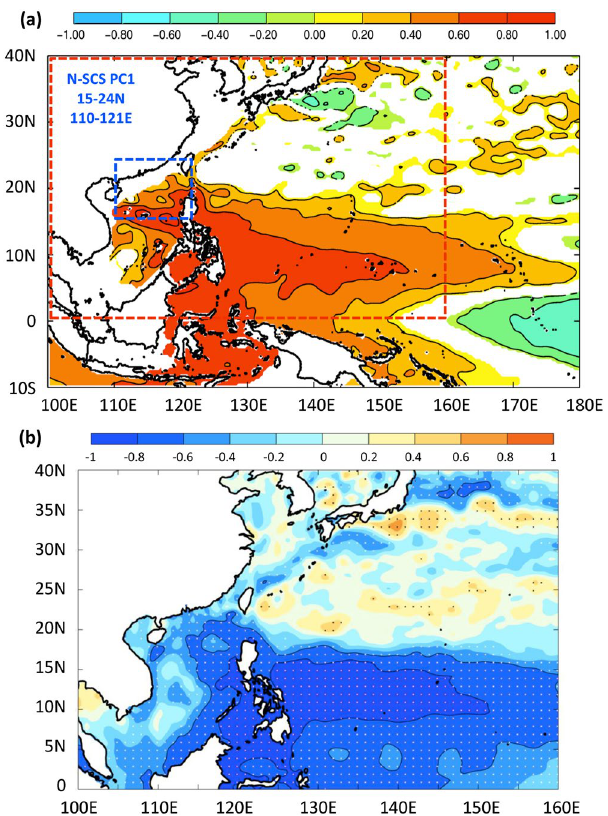
Figure 4. ( a ) Homogeneous correlation map of mode-1 northern SCS EOF( η ’) (57%; domain shown in blue) with AVISO SLA in the western North Pacific from 1993–2013, showing that the SCS η ’ is closely related to the SLA fluctuations over the warm pool, in particular to the fluctuations in the vicinity of the NECBF point near 12~13 o N. ( b ) Correlation between NECBF with AVISO SLA in the red domain of ( a ); dots show correlations significant at the 95% confidence level. In SCS and warm pool, SLA drops (rises) as NECBF shifts north (south) [Chang and Oey 2012]. Maps plotted using MATLAB Version#R2012a (7.14.0.739) 64-bit (glnxa64)